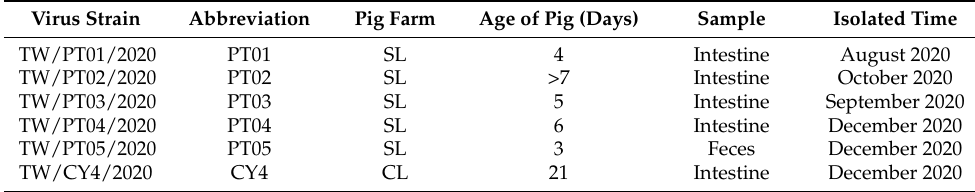
Table 1. Field strains of PED virus collected from piglets with diarrhea. Virus